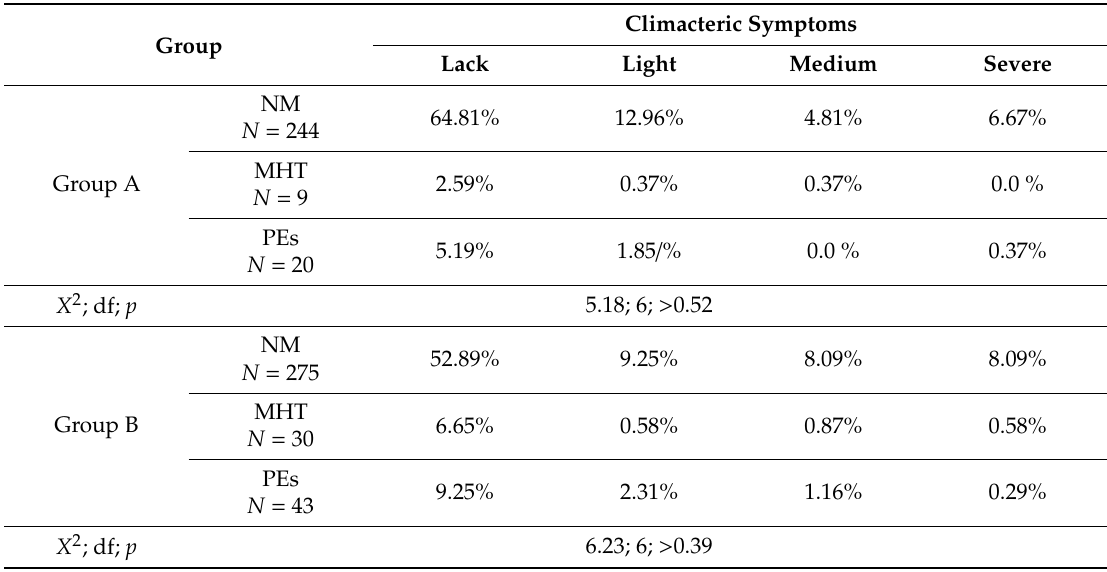
Table 3. Results of Kupperman Index depends on presence or lack of hormonal replacement therapy in study group (group A) and control group (group